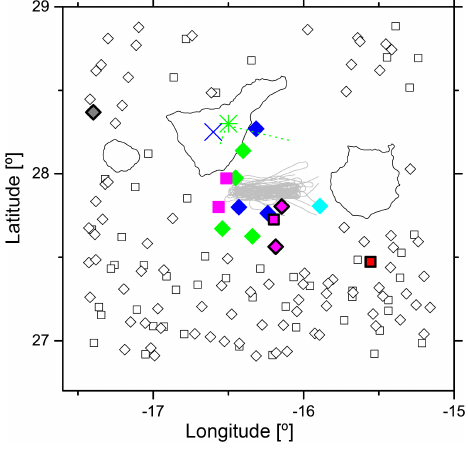
Figure C1. Site map indicating the location of the different instru- ments and ground pixels during the aircraft campaign on 6 days in July 2013. Green star: Izaña Observatory (location of the first Pi- carro and the FTIR; the green dashed lines indicate the line of sight of the FTIR between 08:15 and 13:30UT); blue star: Teide Obser- vatory (location of the second Picarro); grey lines: aircraft flight track during ISOWAT measurements; black squares and diamonds: cloud-free ground pixels of IASI-A and IASI-B, respectively, dur- ing the six aircraft flights; red filled squares and diamonds: pixels that fulfil our coincidence criteria for IASI-A and IASI-B, respec- tively, whereby the different filling colour corresponds to the 6 dif- ferent days as in Figs. 3 and